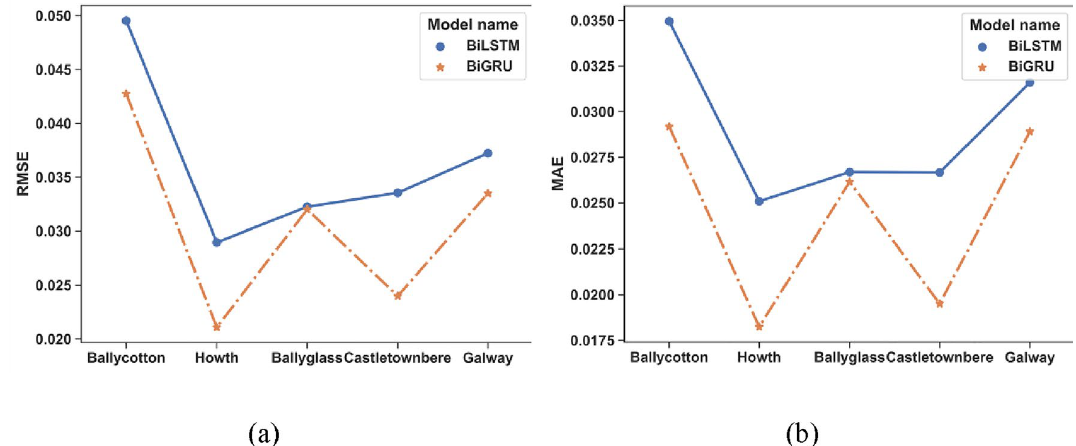
Figure 10. Comparison of prediction effects between BiLSTM and BiGRU on different sites.